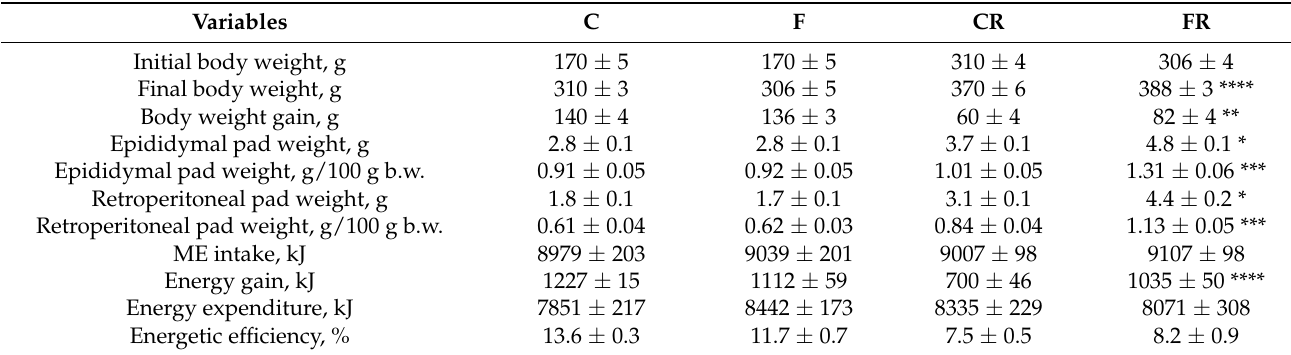
Table 2. Body weight and energy balance after three weeks of high fructose feeding or after three weeks of control diet following three weeks of high fructose feeding.